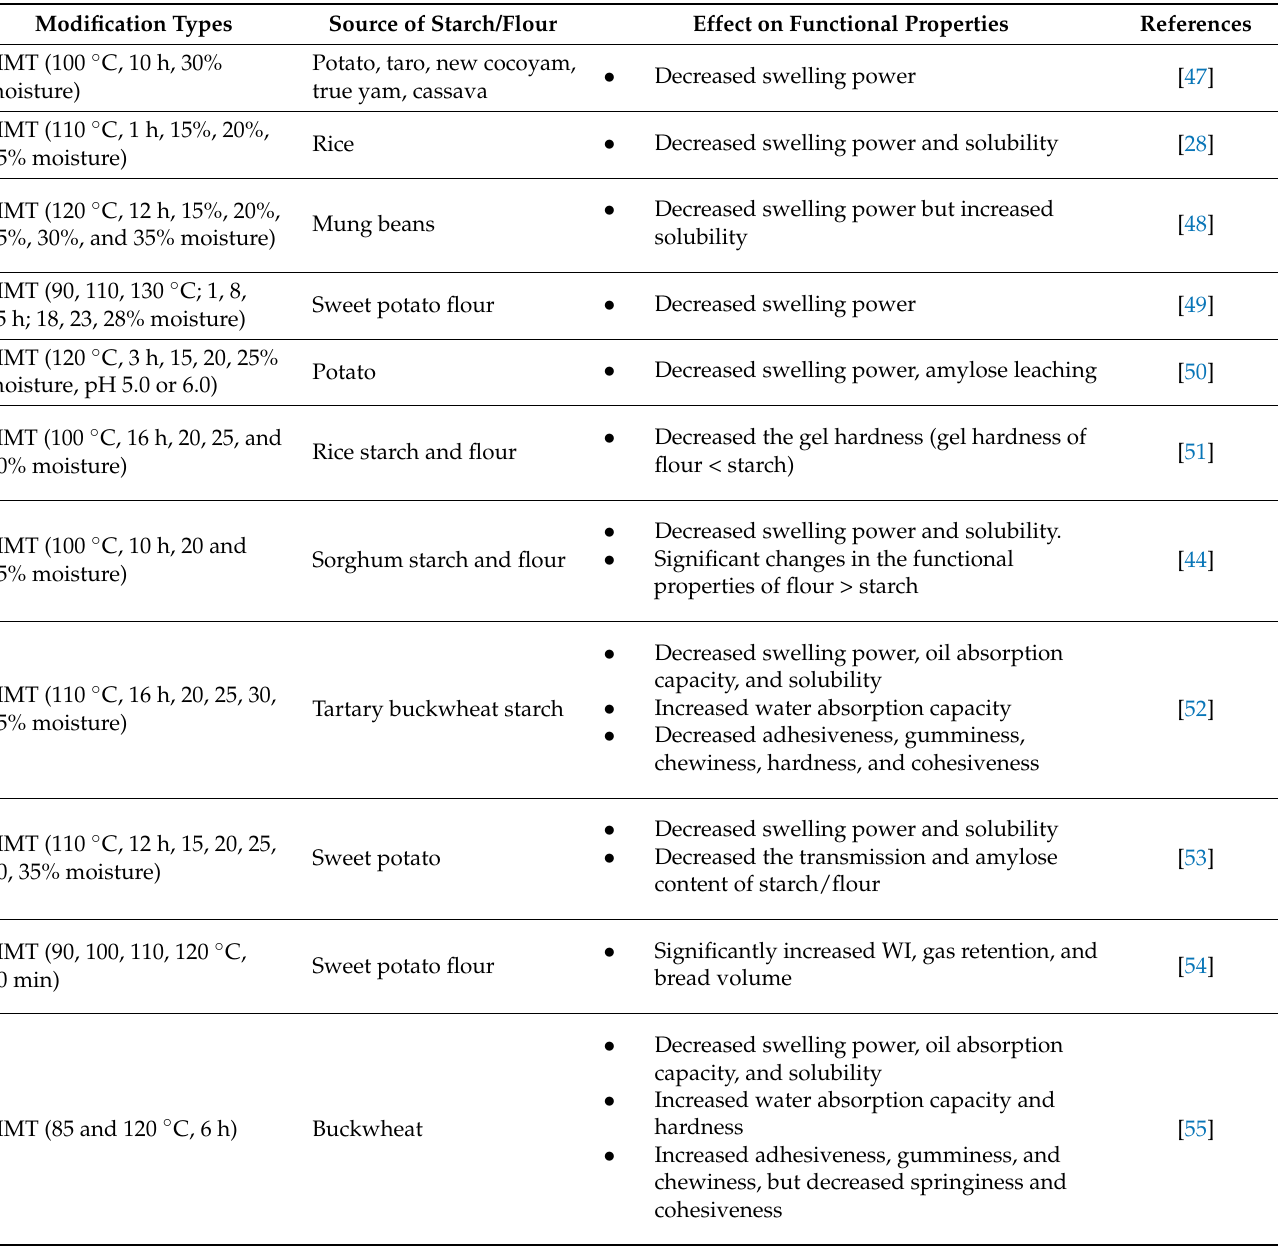
Table 1. Several studies related to the effect of hydrothermal modifications on the functional proper- ties of starch and